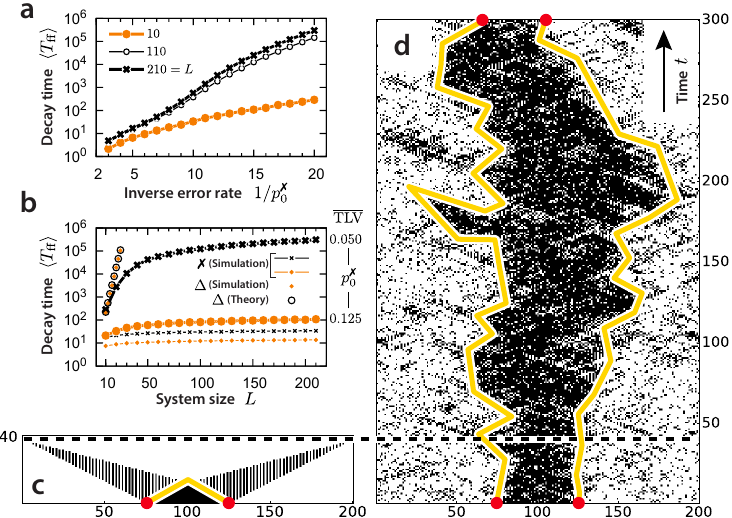
〉 vs. the Figure 8: Noise-induced deconfinement. a Average time to the first majority flip 〈 T ff (cid:55) for different system sizes L = 10,...,210 for TLV. The inverse microscopic error rate 1 / p 0 (cid:55) is approximately exponential. b The same data vs. the system size L dependence on 1 / p 0 (cid:55) = 0.050 and 0.125 (joined bold crosses and bullets for TLV). The for different error rates p 0 〉 for L → ∞ , i.e., the numerics clearly suggests that there is no exponential growth of 〈 T ff storage time of the encoded qubit grows considerably slower than for global majority voting ( ∆ ) with constant correction rate; for comparison, we show simulations and theory for ∆ with (cid:55) = 0.125 (disjoined bullets and circles). With no correction ( (cid:55) ), 〈 T 〉 becomes almost con- p ff 0 (cid:55) = 0.050 and 0.125, respectively). For statistics, stant (joined small crosses and bullets for p 0 we sampled 10 3 evolutions per data point to measure T ; the standard error of the shown ff sample mean is ∼ 3% such that the error bars are not visible. c Spacetime diagram of a large (cid:55) = 0) and TLV- evolution. d Evolution of the same initial cluster without continuous noise ( p 0 (cid:55) = 0.1 and the same scale as in c . Note that the messaging be- state with continuous noise p 0 tween left and right boundary of the cluster is jammed by the noise within the cluster, leading to an effective deconfinement of the charges at the cluster